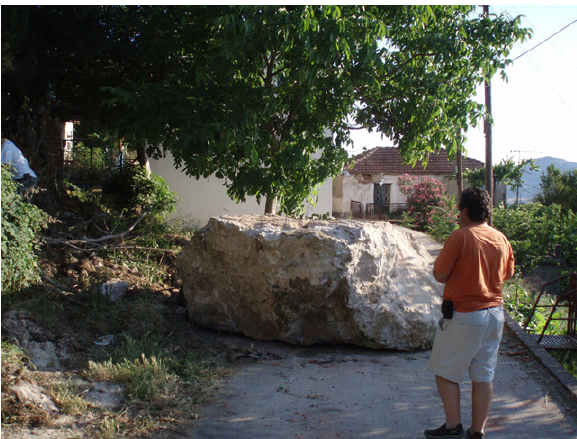
Figure 11. Example of large size rock-fall in the village of Santomeri. Figure 12. Slope failure close to the village of